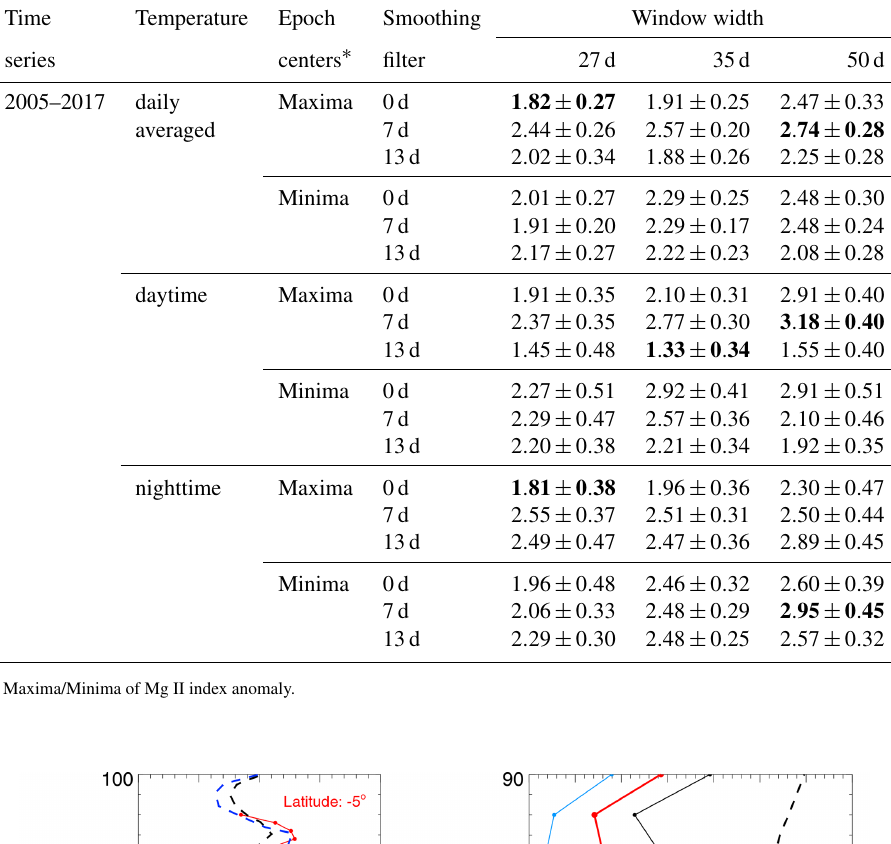
Table 2. Sensitivity (unit: kelvin per 100 solar flux units ) and the uncertainties of different cases at a latitude of 5 ◦ N and altitude of 88km. The sensitivity value is linearly fitted by the time lagged epoch-averaged temperature anomaly with the epoch-averaged Mg II index anomaly. The values in bold font correspond to the maximum and minimum of the sensitivity value for the daily averaged, the daytime and the nighttime measurements.